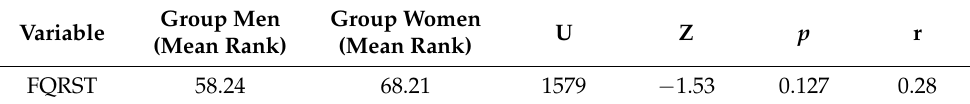
Table 5. Comparison of recorded parameters (Mann–Whitney test) between the group of men ( n = 71) and the group of women ( n = 53), grouping variable IPAQ category. Group Men Group Women U Z p r Variable (Mean Rank) (Mean Rank) FQRST 58.24 68.21 1579 − 1.53 0.127 0.28